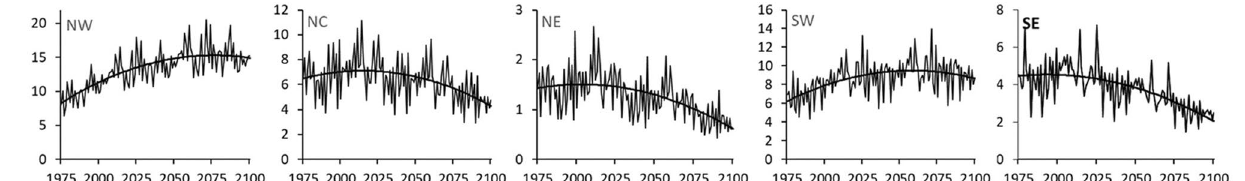
Figure 4. Annual volume demand in billion cubic metres for irrigation water in the base case for the five regions of Bangladesh. The thicker smooth lines are fitted functions of the form Y = a1 + a2.X + a3.x 2 . Note that the scales differ in the different